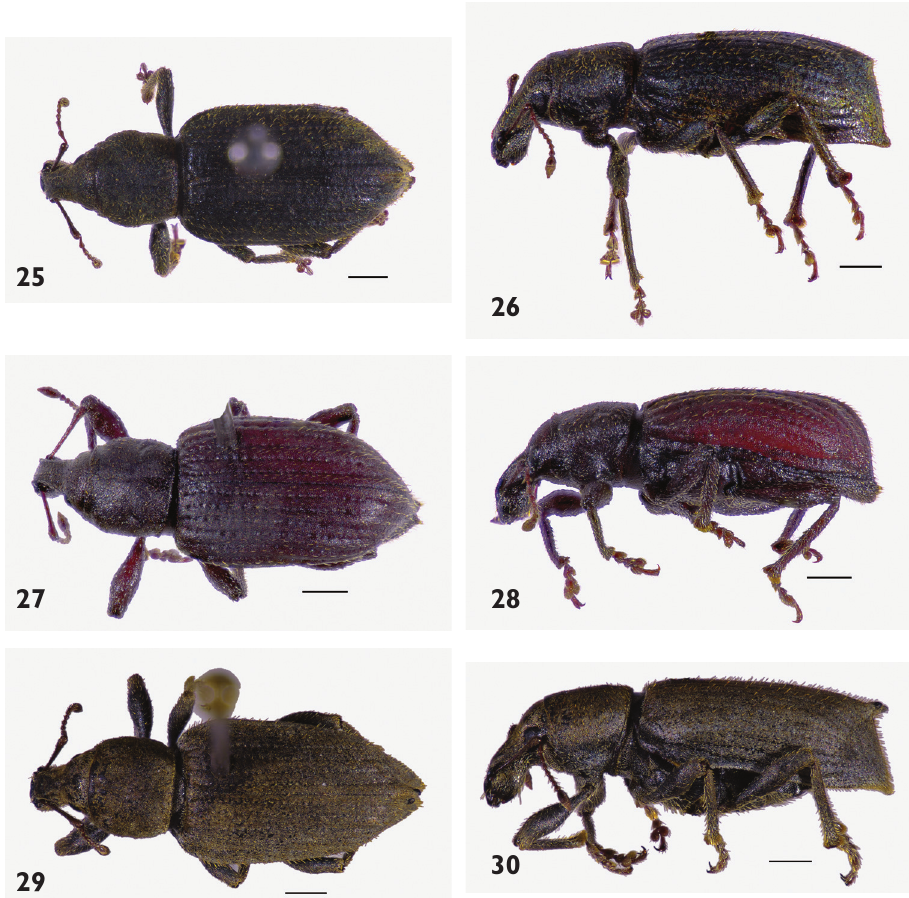
Figures 25–30. Habitus photographs of Austromonticola females. 25, 26 A. postinventus , holotype 27, 28 A. planulatus , holotype 29, 30 A. inflatus , holotype. Scale bars = 1 mm.